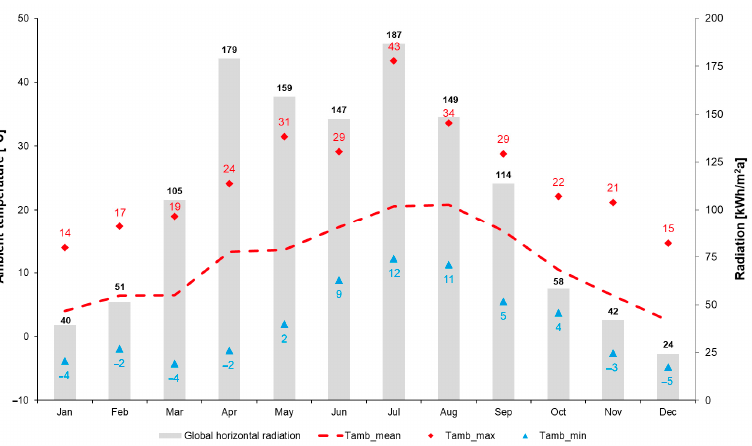
Figure 7. Cumulative global horizontal radiation and maximum, minimum, and average ambient temperatures per month measured in Munich 2020 (own representation).